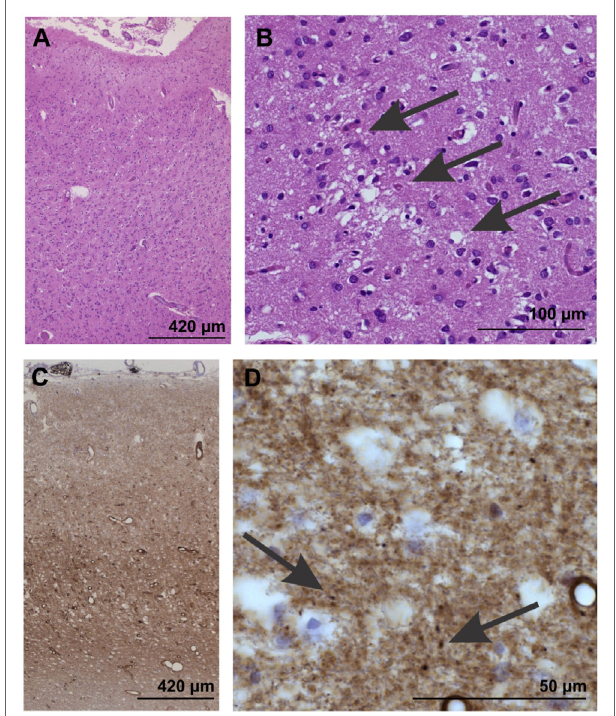
FIguRe 2 | Neuropathological confirmation of Creutzfeldt-Jacob disease morphologically by neuron loss and astrogliosis in the temporal neocortex (area 35) as evident in the overview magnification of a hematoxylin and eosin-stained section (a) . Spongiform changes become visible at higher magnification [arrows in (B) ]. (C,D) In the temporal neocortex of Brodmann area 35, the synaptic pattern of the pathological prion protein deposits become evident (C) . At higher magnification (D) , some more condensed, dot-like deposits can be seen (arrows), whereas no plaques or plaque-like lesion were seen. Prion protein antibody used: 3F4, proteinase K, and formic acid pretreatment, 1/100, Dako-Agilent, Santa-Clara, CA, USA.